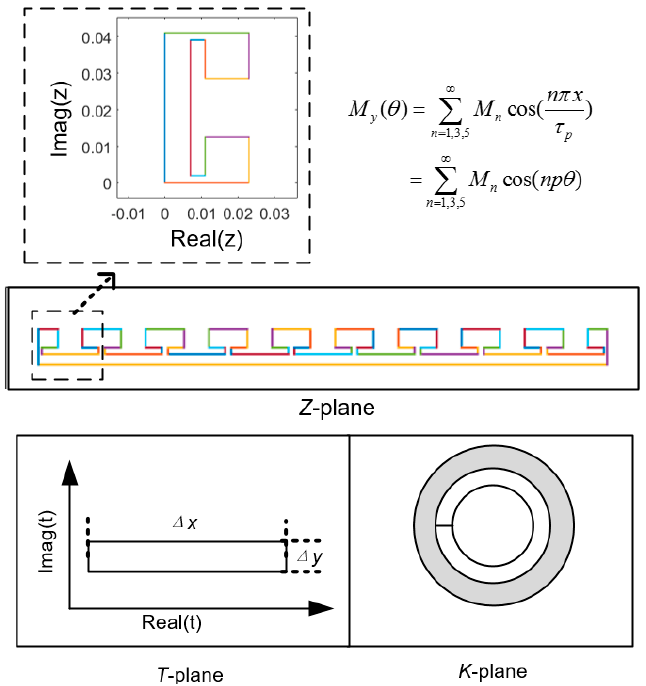
Figure 5. Schwarz-Christoffel (SC) mapping in different plane.